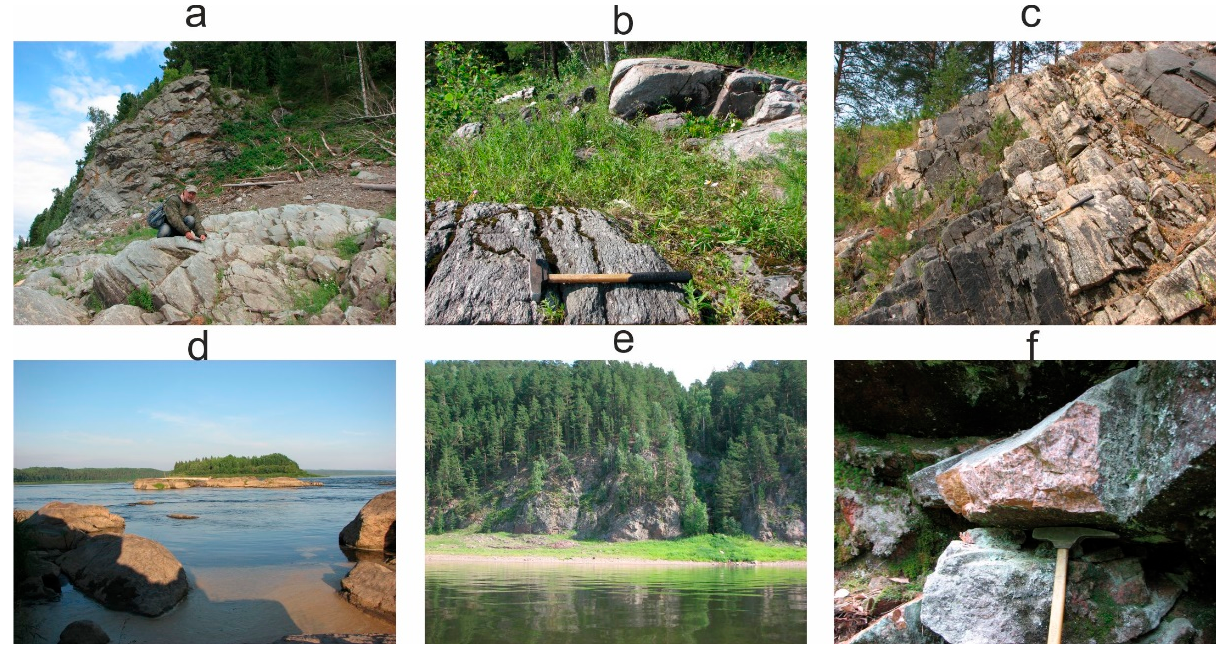
Figure 6. Field photos of rock outcrops: ( a ) the Nemtikha Group plagiogneiss granite rocks, ( b ) Malaya Garevka Group rapakivi-type granites, ( c ) the dyke localities exposed along the Yenisey bank, ( d ) granitoids of the Ostrovok island, and ( e , f ) granites of Chernorechensky